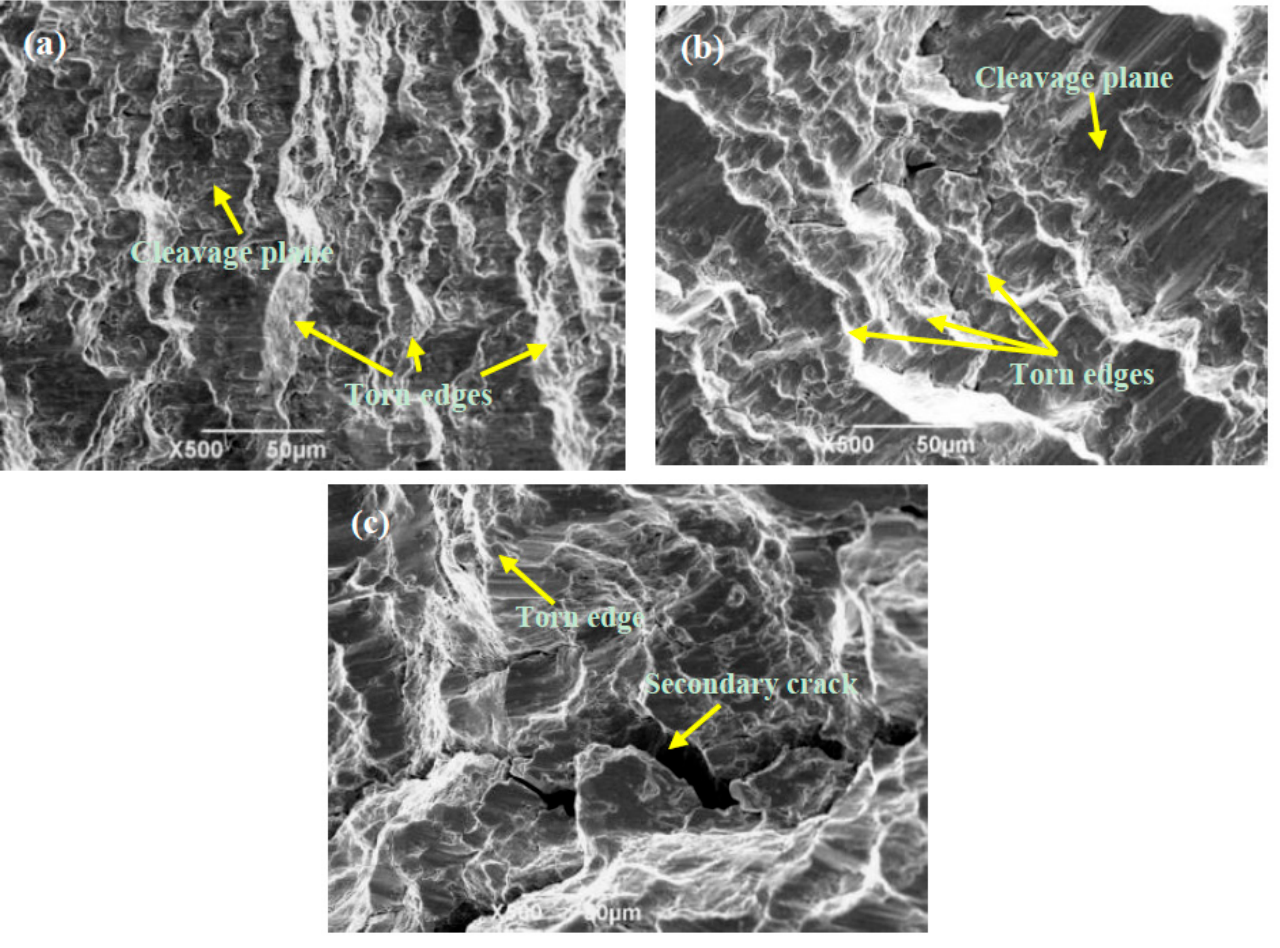
Figure 12. Fracture morphologies of fatigue crack propagation zone under 90° non-proportional tension–torsion loading at different stress amplitudes. ( a ) S eq = 458.6 MPa, ( b ) S eq = 509.6 MPa, ( c ) S eq = 622.4 MPa.